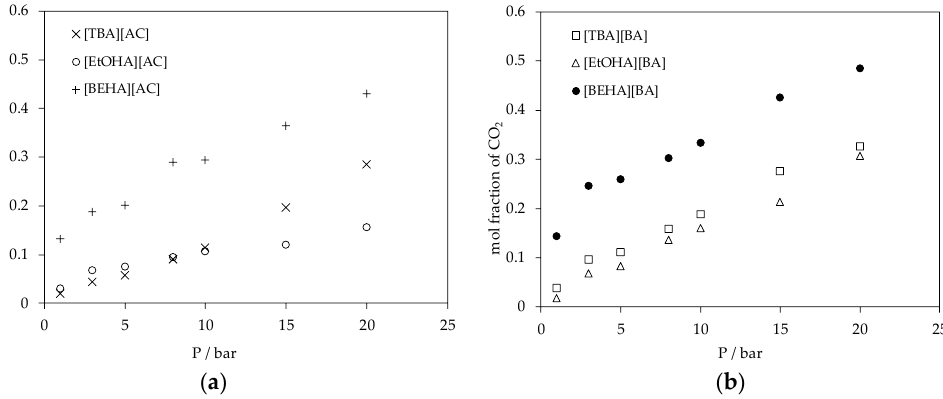
Figure 7. Plot of CO 2 absorption in ammonium-based protic ionic liquids at 298.15 K.